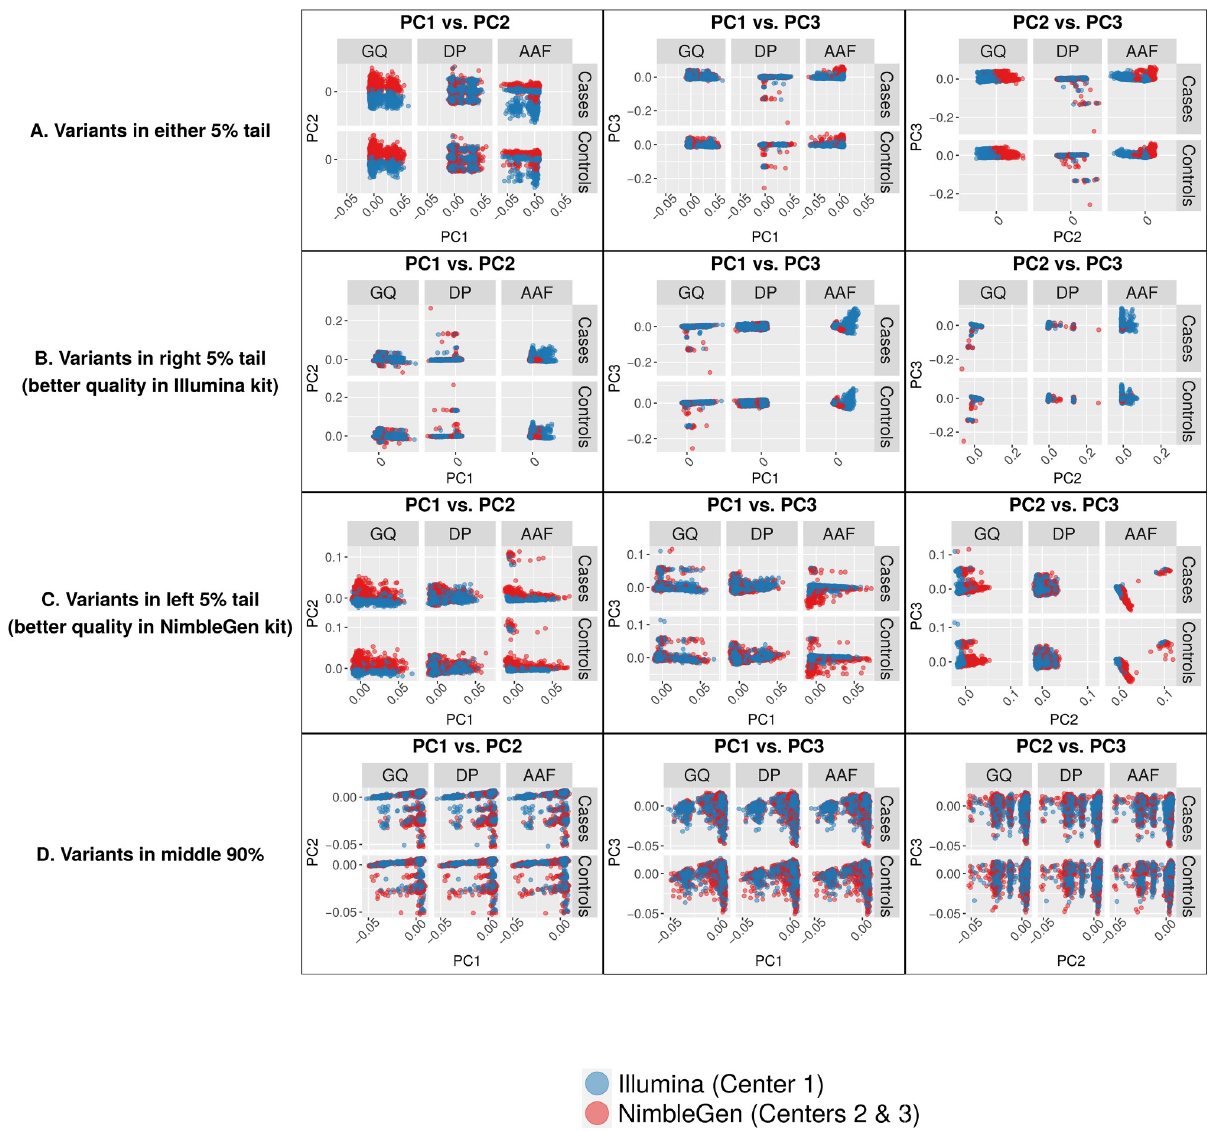
Fig 6. PC eigenvector plots of genotypes at variants lying in different sections of quality-metric ratio distributions. Each data point represents a single individual, color coded according to capture kit. (A) PCs of variants in either 5% tail. (B) PCs of variants in right 5% tail. (C) PCs of variants in left 5% tail. (D) Variants in middle 90% of distributions. Variants in the tails, in particular the left 5% tail (better quality in NimbleGen kit), show clear separation by capture kit in both cases and